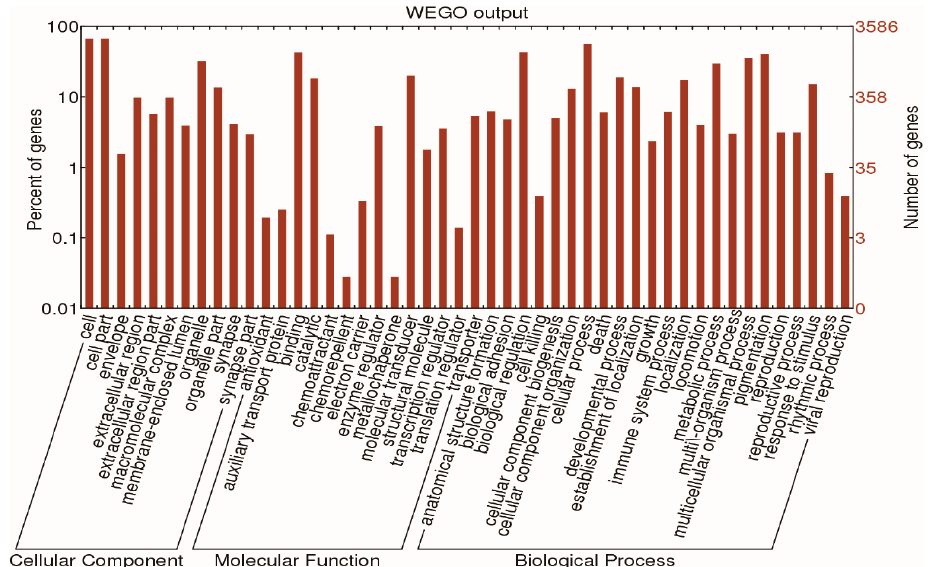
Figure 1. Web Gene Ontology Annotation Plot (WEGO) analysis of the differential expression genes. The impact of AC3 deletion on the regulation of genes is associated with biological activities such as growth and development, metabolism, ion transport, energy conversion etc. in the MOE. Table 1. Pathway analysis of the differentially expressed genes by using the KEGG database.